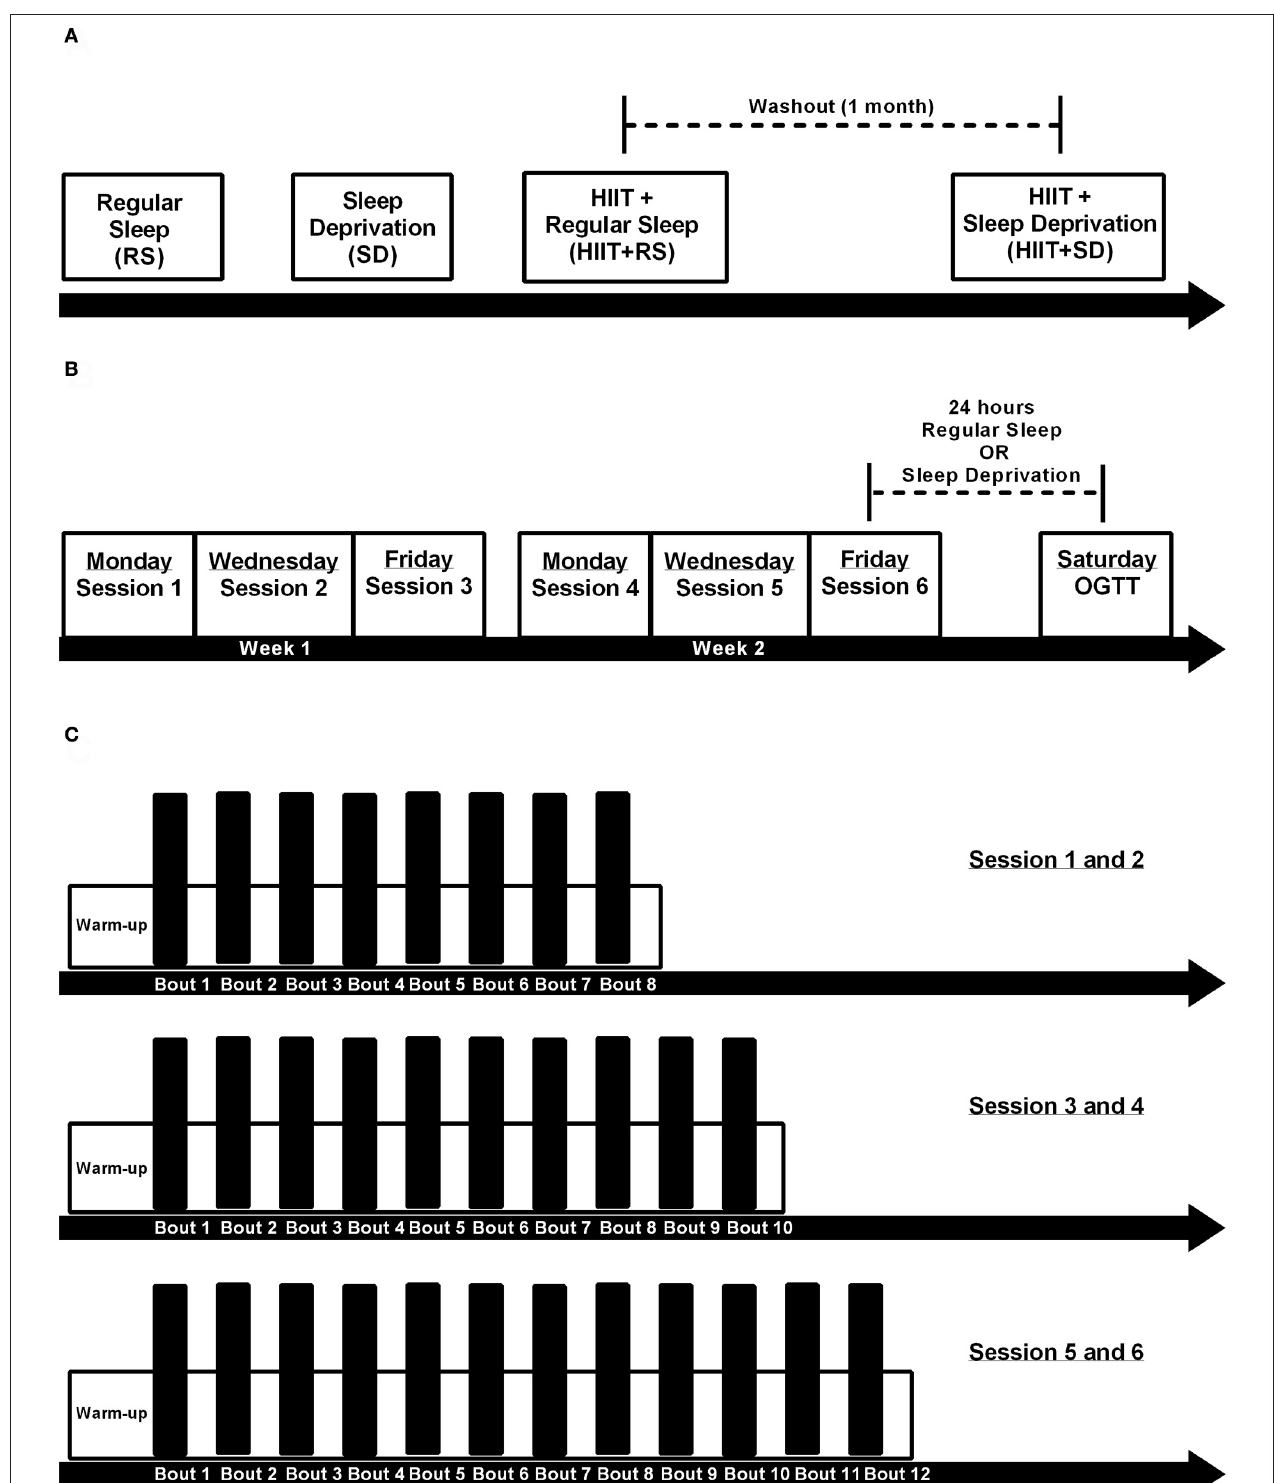
FIGURE 1 | Experimental design. (A) Order of experimental conditions, where first the volunteers were submitted a single night of regular sleep (RS condition), second the volunteers were submitted 24h sleep deprivation ( SD condition), third the volunteers were submitted 2 weeks of HIIT training and after last session had a night of regular sleep (HIIT + RS condition), and after a month of washout the volunteers repeated the 2 weeks of HIIT training and after last session had a 24h sleep deprivation (HIIT + SD condition); (B) Each training session distributed over 2 weeks; (C) Design of 1-6 HIIT training sessions.